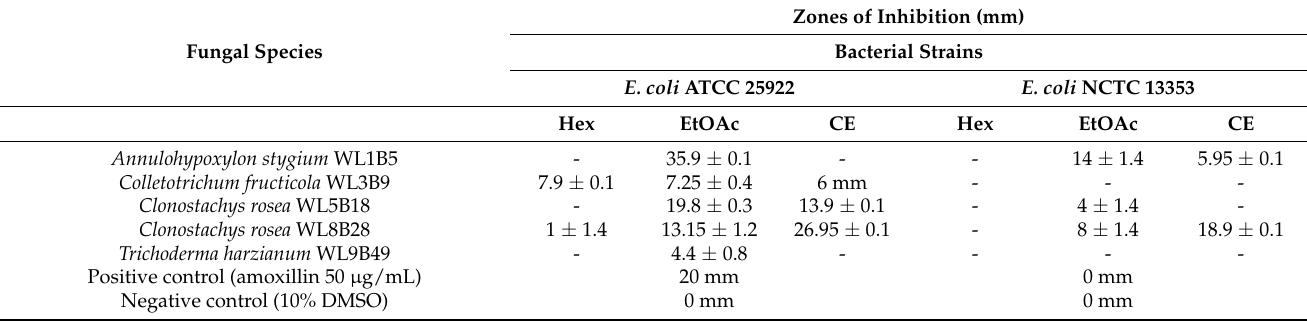
Table 3. Antibacterial activity of different solvent extracts based on hexane, EtOAc and crude extraction of fungal isolates from the Mind ú stream assessed with E. coli ATCC 25922 and an ESBL- positive E. coli NCTC